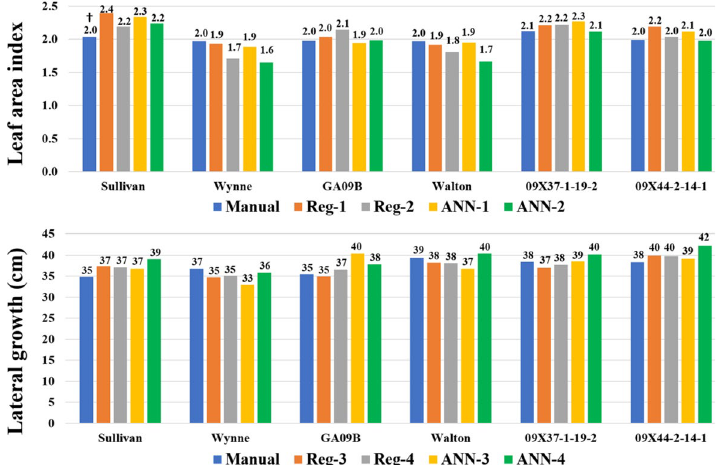
Figure 11. Bar graph showing Leaf area index (LAI) and lateral growth (LG) of six peanut genotypes. The LAI and LG values of each genotype include manually taken values and derived values using four models (Reg-1, Reg-2, ANN-1, ANN-2 for LAI; and Reg-3, Reg-4, ANN-3, ANN-4 for LG). The LAI measurements are from 45 days after planting (DAP) and LG are from 40 DAP. †LAI and LG values within each genotype are not significantly different using Tukey’s HSD at α = 0.05.